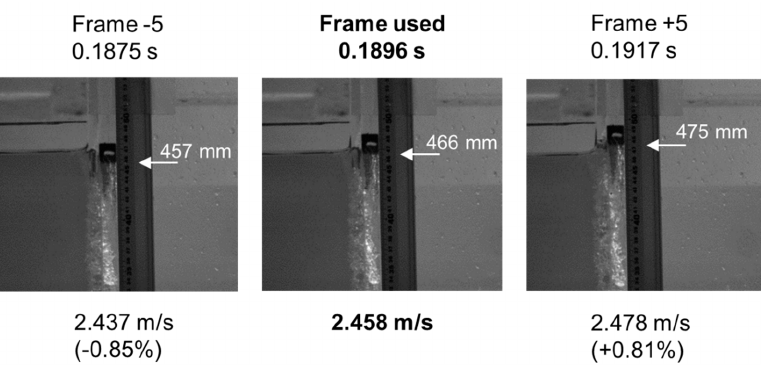
Figure A1. Three snapshots when the tip of the acrylic gate was about to detach from the water.